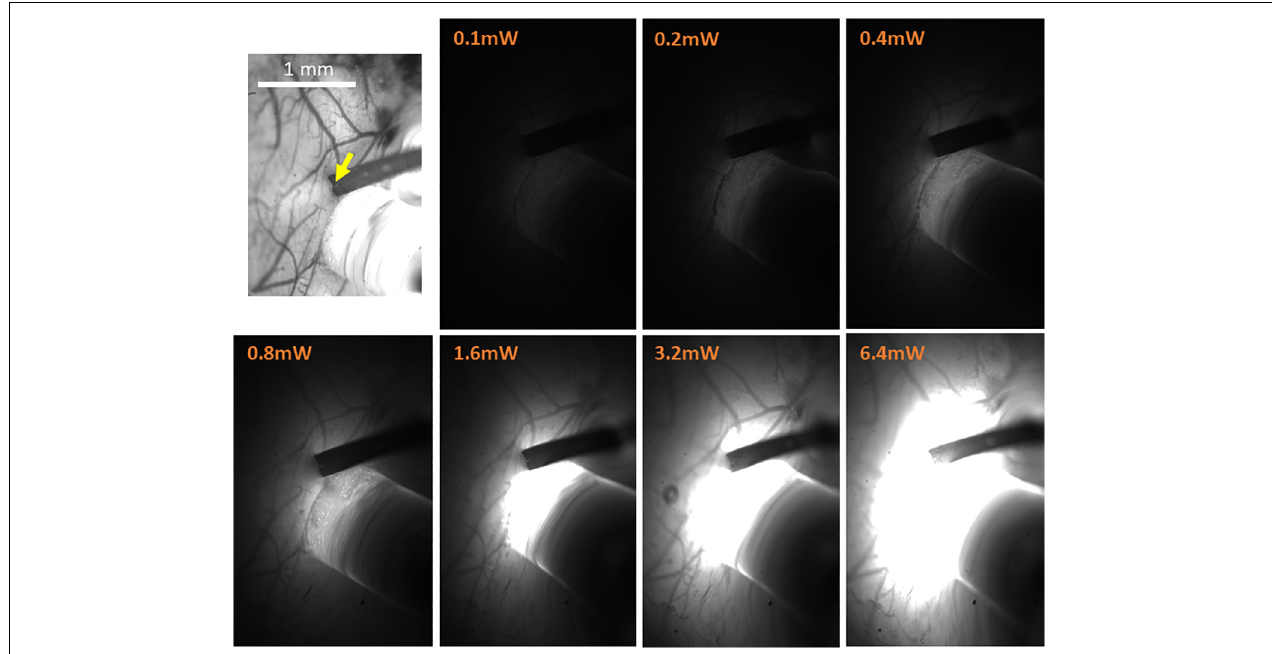
FIGURE 6 | High-resolution imaging of the spatial extent of the optic fiber photostimulation. The top-left panel presents the high-resolution reference image taken under illumination wavelength of 530 nm, just prior to the electrophysiology recordings. It features the pial vessel topography and the electrode insertion site (yellow arrow). The scale bar represents 1 mm. The next seven panels show the optic fiber illumination of the region of interest at the indicated output power of amber light (wavelengths distribution centered on 590 nm; used with eNpHR3.0), taken in otherwise complete darkness and with identical imaging